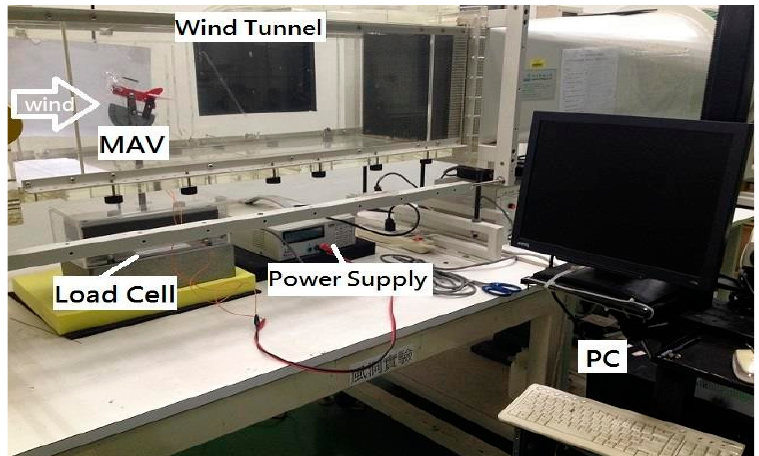
Figure 6. Wind tunnel experiment set up.